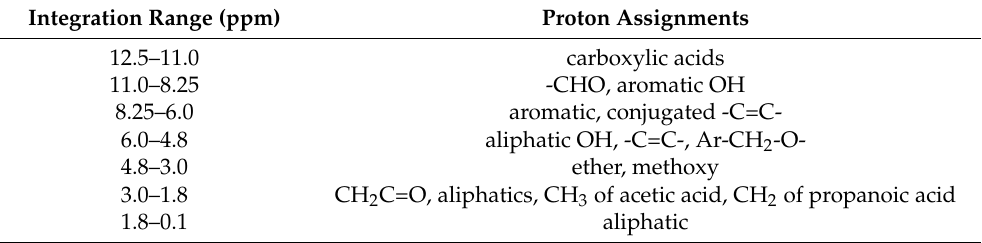
Table 2. Integration ranges and respective proton assignments for proton magnetic resonance